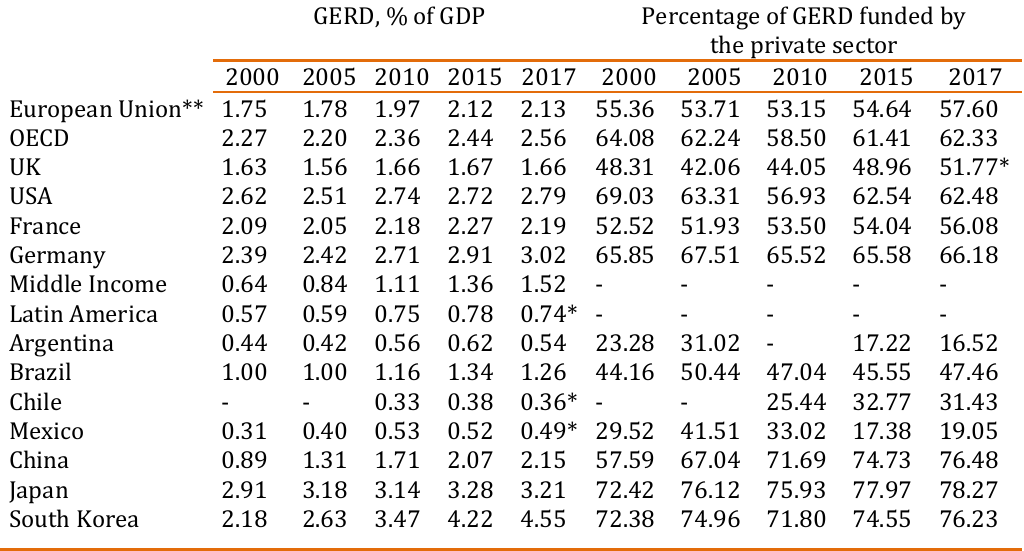
Table 01 . GERD as a share of GDP and GERD funded by private businesses, selected countries and years GERD, % of GDP Percentage of GERD funded by